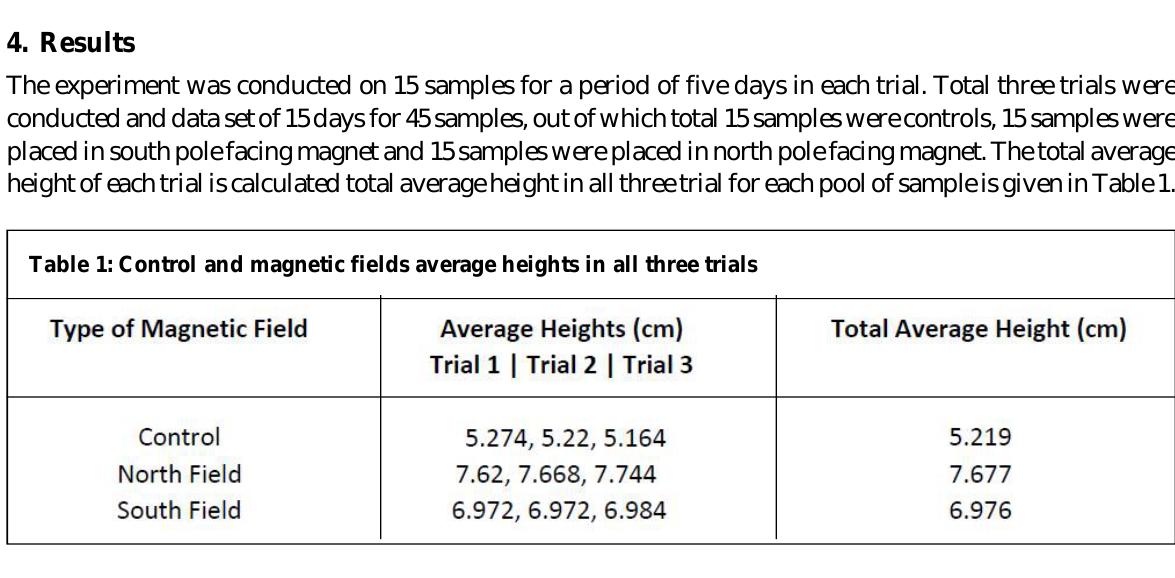
All the height averages from all three trials have been calculated. The average height of all the controls is 5.219 cm. The total average height for samples placed in north field is 7.677 cm and for the south field is 6.976 cm.